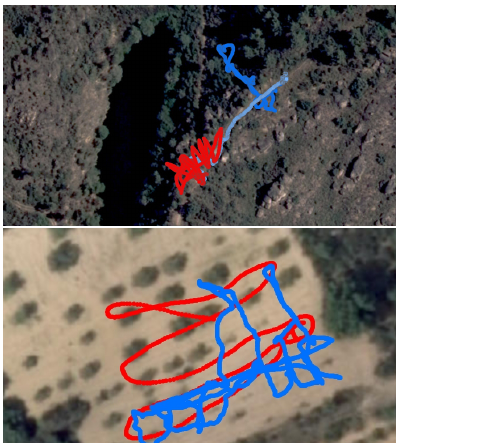
Figure 23. Monitoring flight in Scenario A. ( left ) Map of flight in blue, (scouting drone path in red). ( right ) 3D scenario with path and estimation of surface sources are presented by circles.